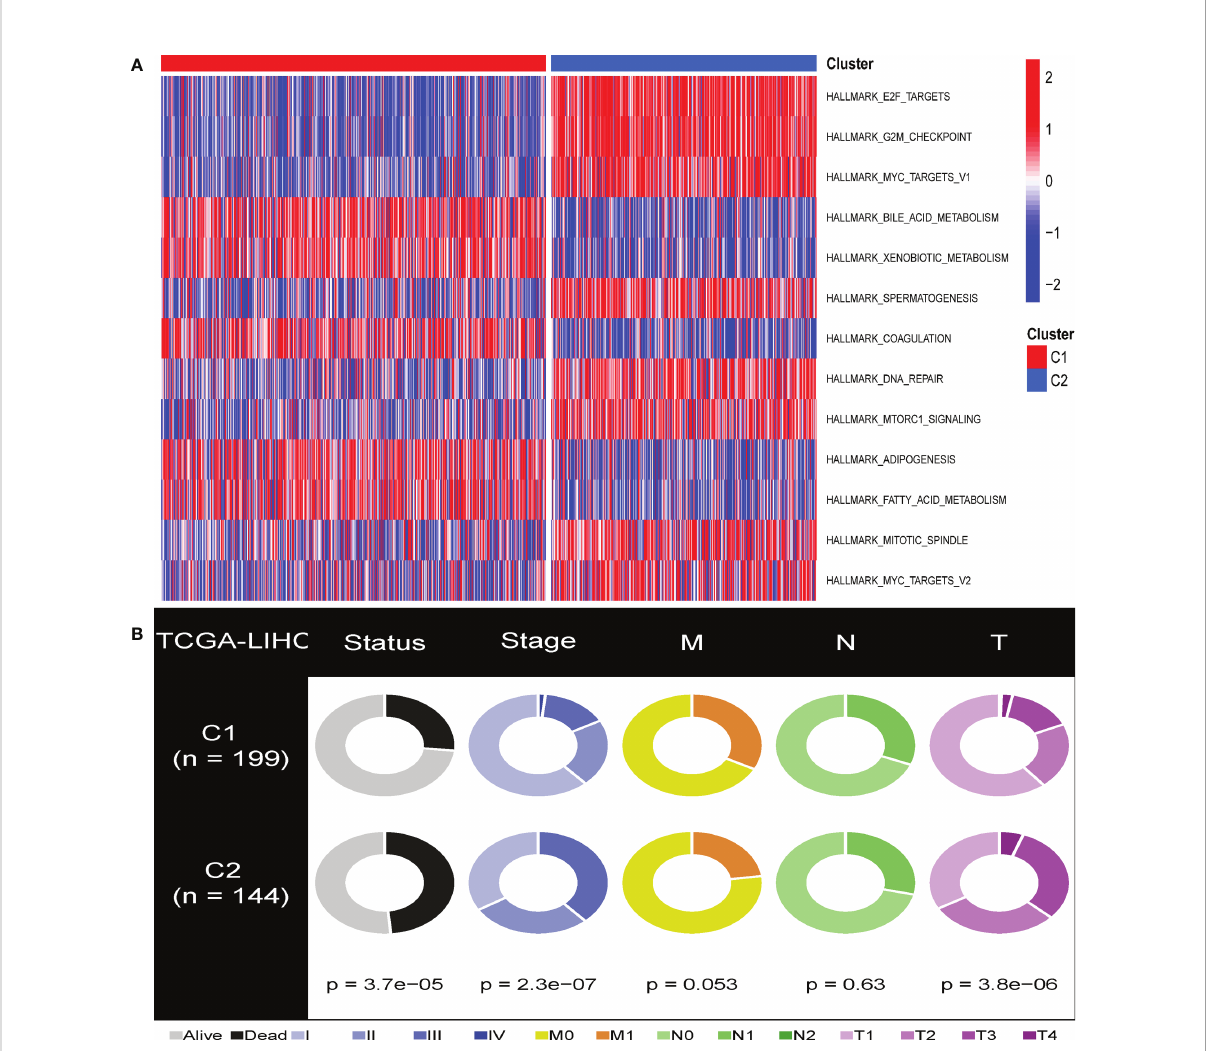
FIGURE 2 GSVA analysis of the senescent-enrichment pathway hallmarks and clinical characteristics in distinct CS patterns. (A) The differences between the C1 and C2 subtypes in the enriched hallmark pathways. (B) Pie charts illustrated the different distribution of clinical characteristics between the two subtypes between C1 and C2 subtypes in TCGA-HCC